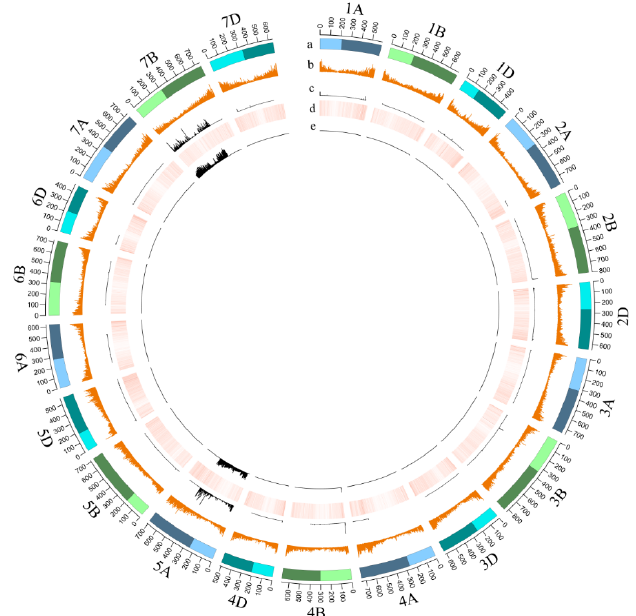
Figure 1. Distribution of expressed genes and SNPs on chromosomes in CASL7BS based on the transcriptome and resequencing data. a: The length of chromosome and the position of centromere in wheat. The dark part is the long arm of the chromosome, and the light part is the short arm of the chromosome, the labels of 1A to 7D are the chromosome names of wheat, i.e. 1A is for chromosome 1A of wheat; b: the distribution of wheat annotated genes on chromosomes; c: the distribution of homozygous SNP detected by transcriptome data on the chromosome of CASL7BS; d: the distribution of the expressed genes on the chromosome of CASL7BS; e: the distribution of homozygous SNP detected by resequencing data on the chromosome of CASL7BS.